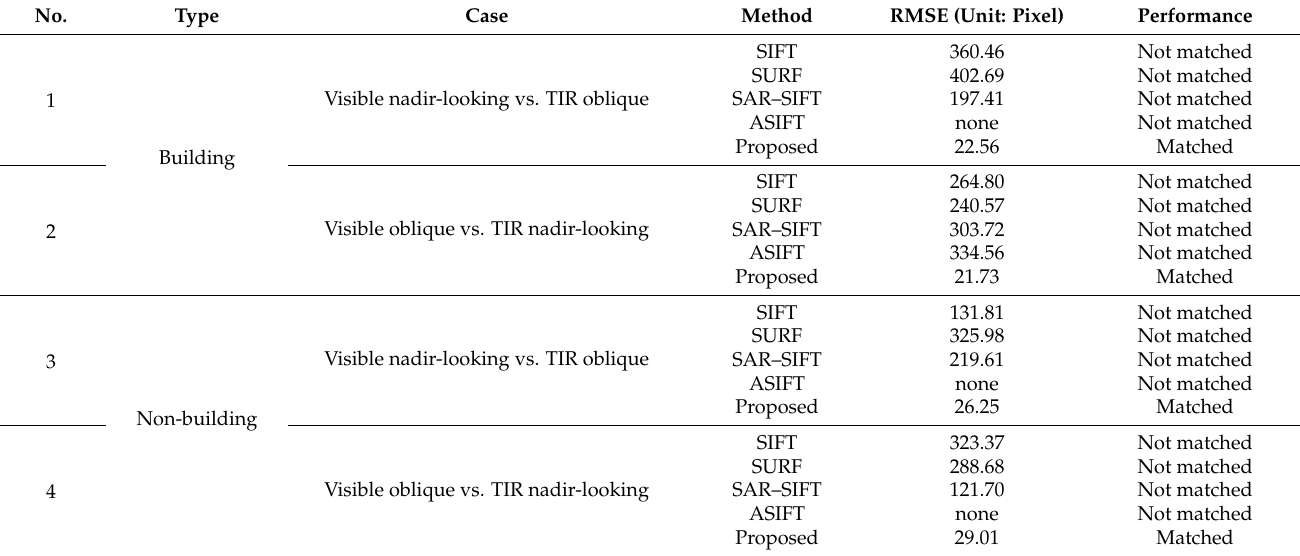
Table 6. RMSEs of pixel distance based on matching